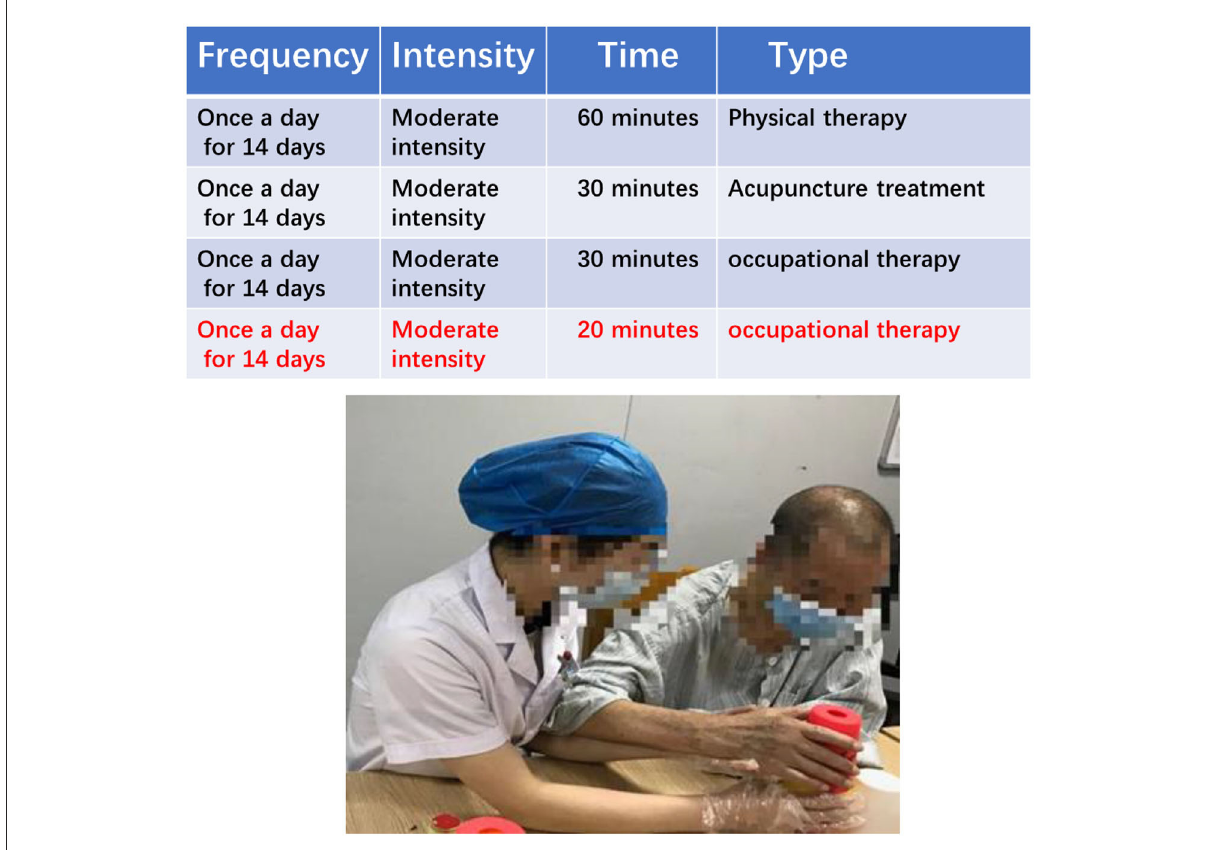
FIGURE2 A rehabilitation therapist and patient in one-on-one training.